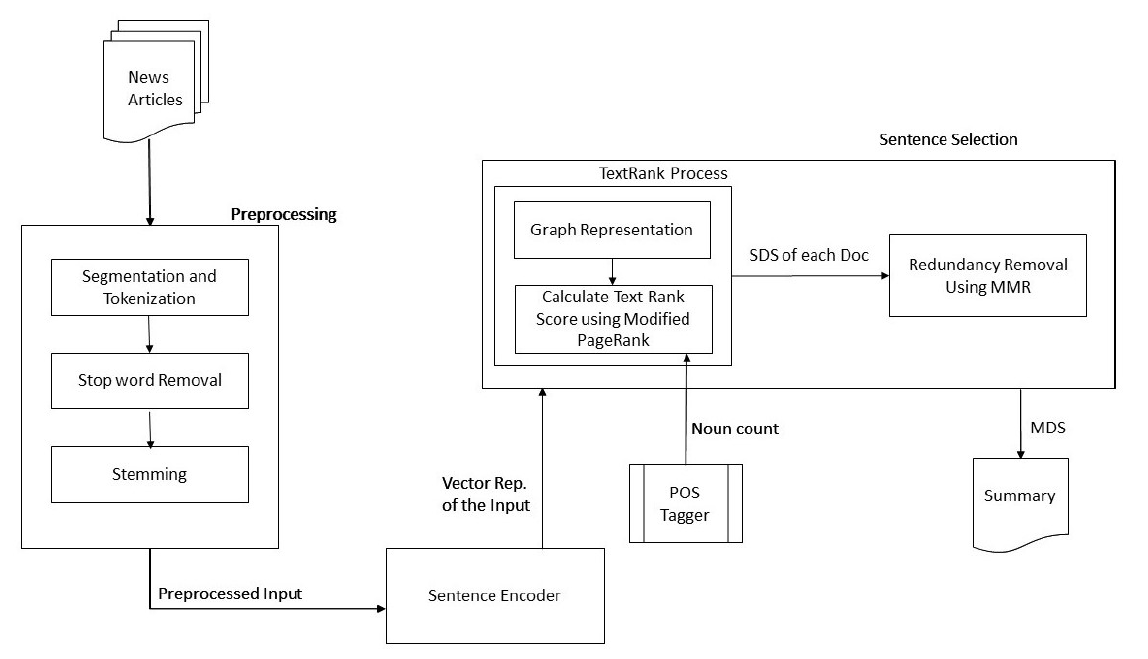
Figure 1. System Architecture of the Framework for Extractive multi-document summarization